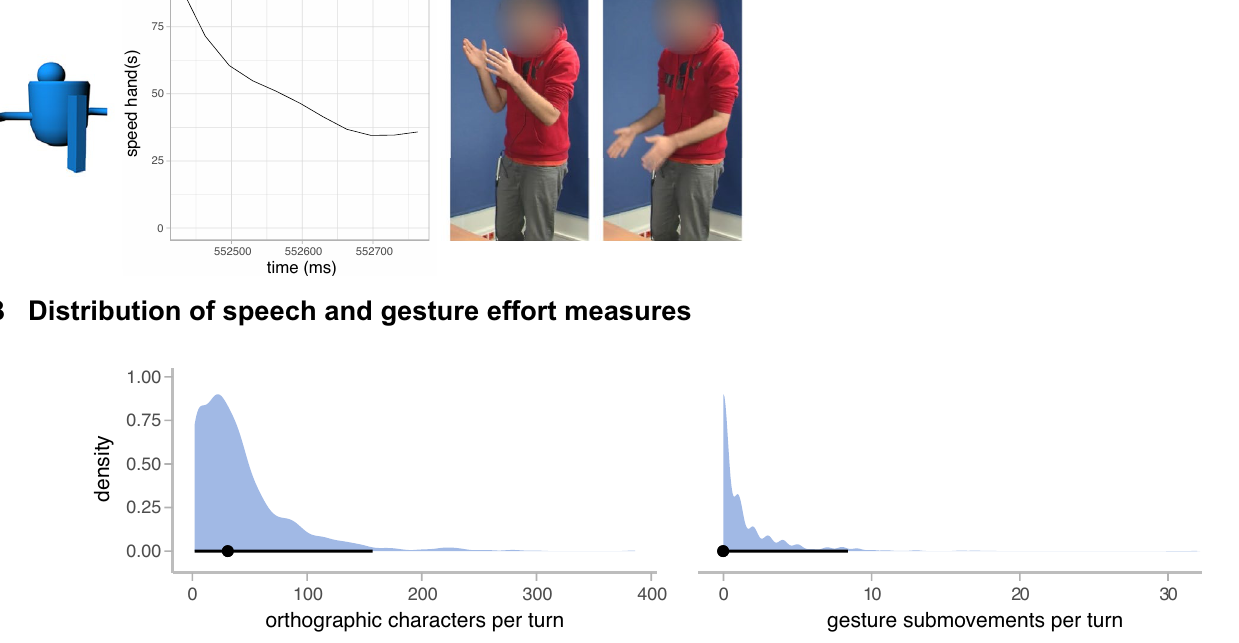
Figure 4. In panel ( A ), the top row shows a gesture which depicts the subpart on the left side of the Fribble. The gesture is produced by a matcher as part of a restricted offer with the following speech: “ah en is zijn arm uh rond maar ook een beetje met hoeken?” [literal translation: ah and is his arm round but also a bit with corners? ]. The right arm is extended to model the ‘arm’, while the left hand is moved around it to depict the angular shape (number of submovements: 4). The bottom row shows a gesture which was produced by a director in a repair solution in response to a restricted offer. The gesture depicts the rectangular subpart on the front side of the Fribble, while saying “ja precies” [ yes exactly ]. The multimodal utterance thereby confirms the preceding restricted offer (which contained an identical gesture). The hands are kept somewhat apart (to depict the width of the rectangle), and moved straight downwards (number of submovements: 1). The density plots in panel ( B ) show the distributions for the speech and gesture effort measures (the dots are the median and the lines the 95% quantile